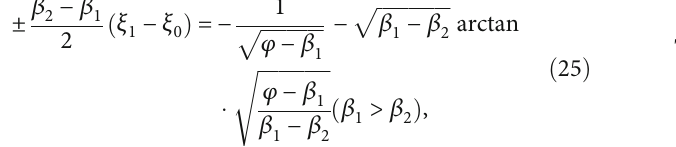
ffiffiffiffiffiffiffiffiffiffiffiffiffiffi p β − β 1 2